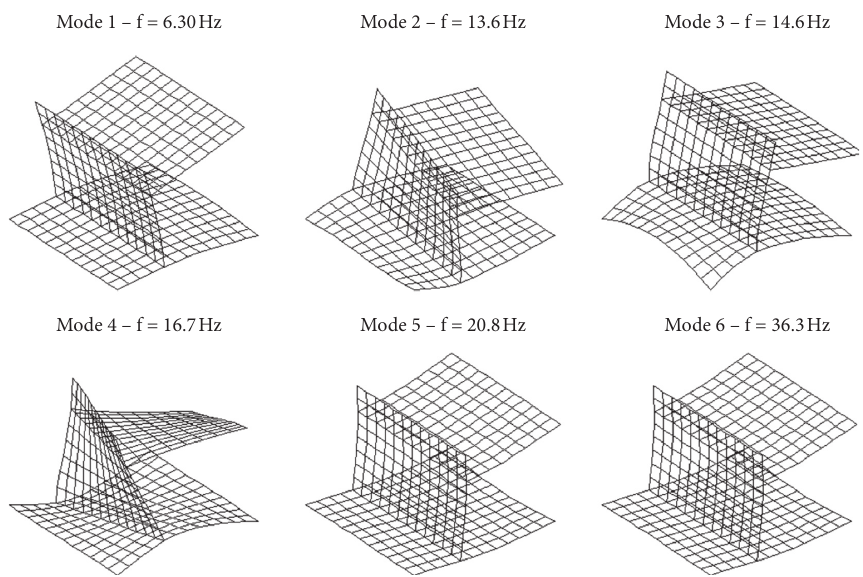
Figure 3: First 6 mode shapes from the FE